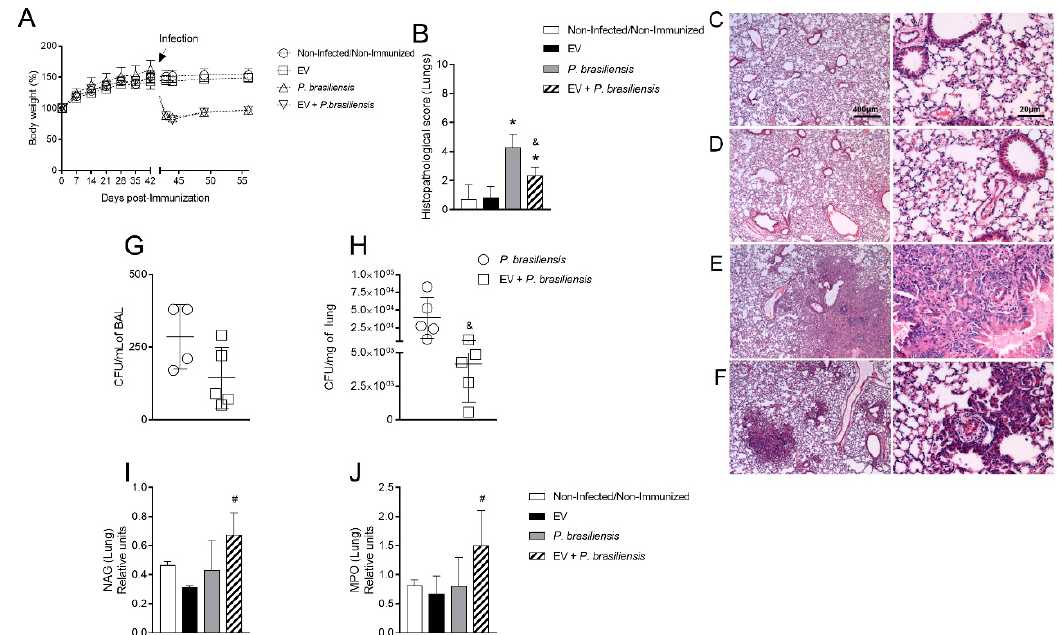
Figure 3. Immunization with EVs from P. brasiliensis alters tissue architecture and reduces fungal burden at lung tissue and the inflammatory profile of lung tissue at day 14 post-infection. Body weight ( A ). Histopathological score ( B ). Lung histology ( C – F , scale bars—left 400 µ m and right 20 µ m). Non-infected/non-immunized group ( C ), EV group ( D ), P. brasiliensis group ( E ), EV + P. brasiliensis group ( F ). Fungal burden in BAL ( G ). Fungal burden at lung tissue ( H ). NAG assay ( I ). MPO assay ( J ). & p ≤ 0.05 compared to P. brasiliensis group. # p ≤ 0.05 compared to non-infected/non-immunized, EV , and P. brasiliensis groups. * p ≤ 0.05 compared to the non-infected/non-immunized and EV groups. Non-infected/non-immunized (control). Immunization for 42 days with two doses of 1000 ng of EV protein with adjuvant (boost dose, without adjuvant, given 14 days after the first dose). Data represents one experiment. n = 6 animals per group.